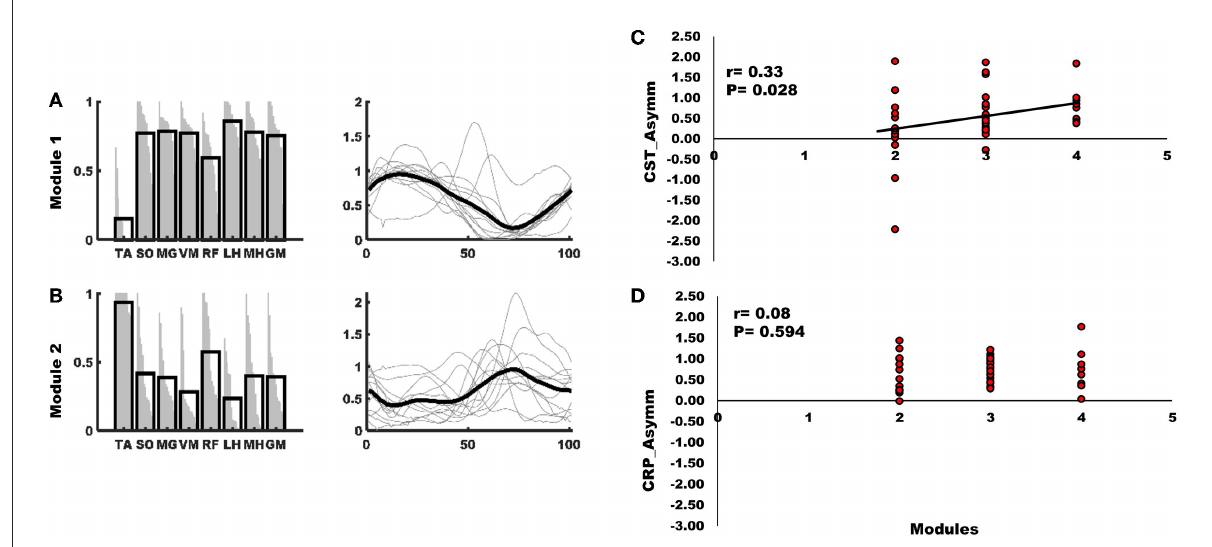
FIGURE5 (A) Module one of the mass flexion-extension pattern had greater activity of SO, MG, VM, LH, MH, and GM and was primarily active during stance. (B) The second module of the mass flexion-extension pattern had greater activity of TA and RF and was primarily active during swing. Each black bar on the left panel of (A,B) indicates group mean of the representation of a muscle within the module and each gray line within the black bar represents a subject. Black line on the right panel of A and B indicates the group mean and gray lines represent the activity profile of the module for each subject. (C) The Asymm Stroke for CST (i.e., fewer CST streamlines on the lesioned hemisphere) were positively correlated with number of modules. (D) The correlation between Asymm Stroke for CRP (i.e., fewer CRP streamlines on the lesioned hemisphere), and number of modules was not statistically significant ( p < 0.05).